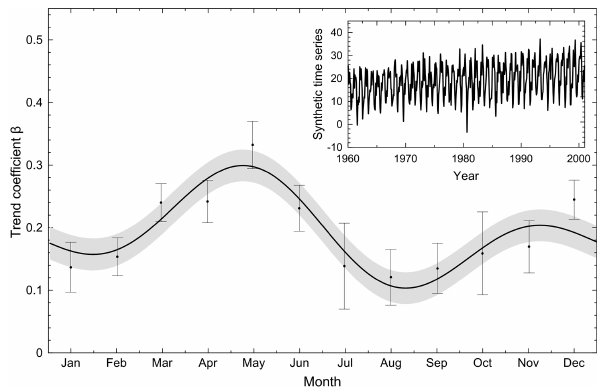
Figure 2. The seasonally resolved trend coefficient derived from fit- ting Eq. (1) (including only the α and β terms) to the synthetic time series (shown in the inset) together with its 1 σ uncertainty (solid black line with grey shaded area). The trends obtained from linear fits to the data from each month separately, together with their 1 σ uncertainties, are shown with black dots and vertical error bars re-